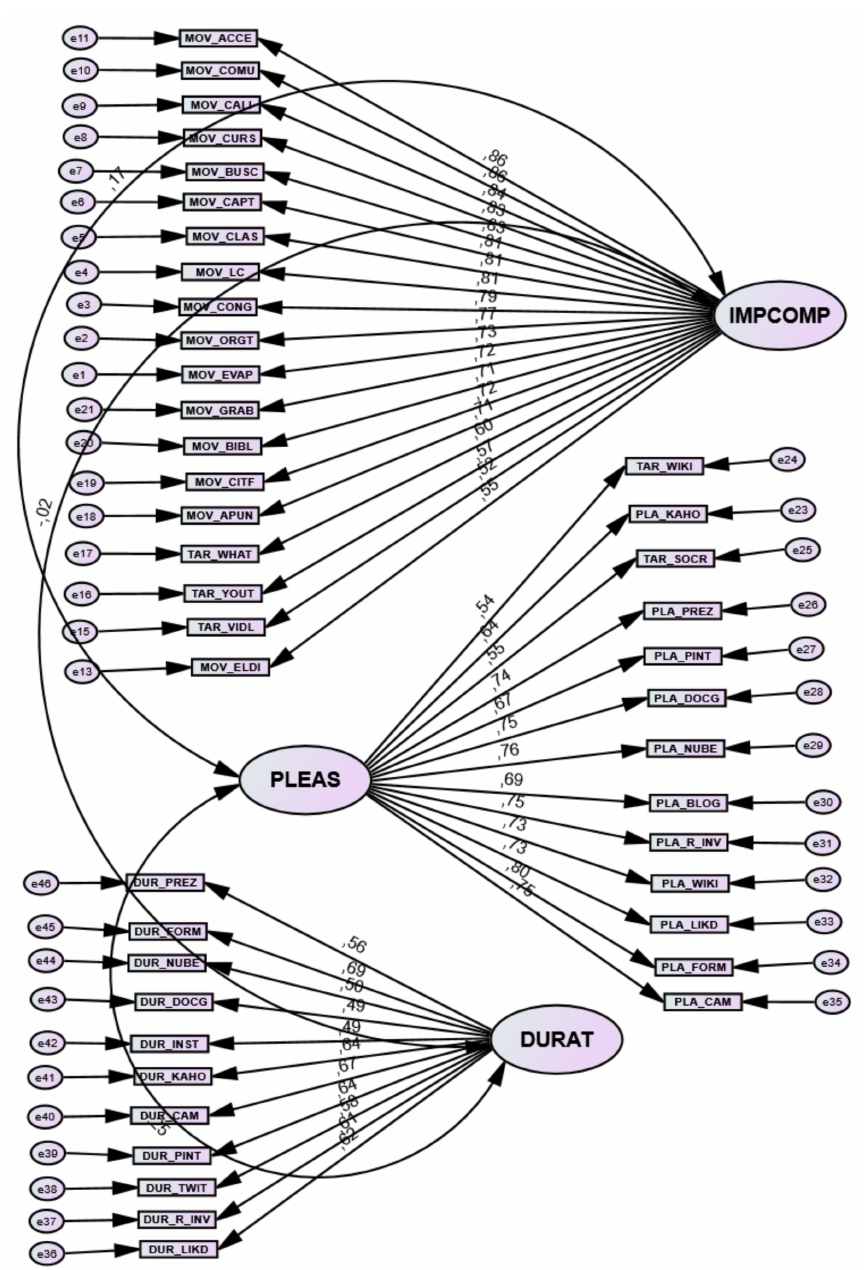
Figure 2. Three-factor measurement model of CFA confirmatory factor analysis of the DTS: IMP- COMP Importance-Competence; PLEAS Pleasurable; DURAT Duration or